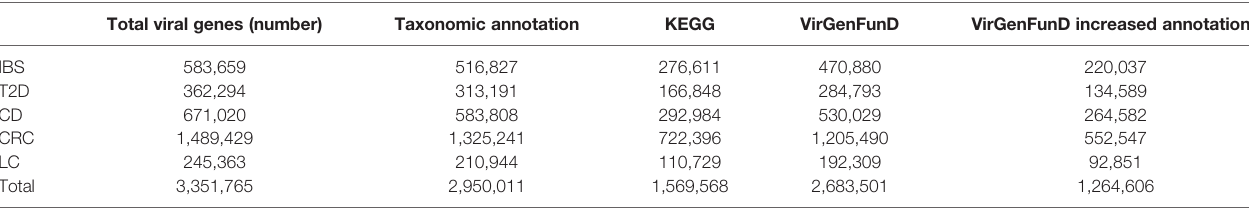
TABLE 1 | Comparison of the number of annotations for viral sequences in VirGenFunD. Total viral genes